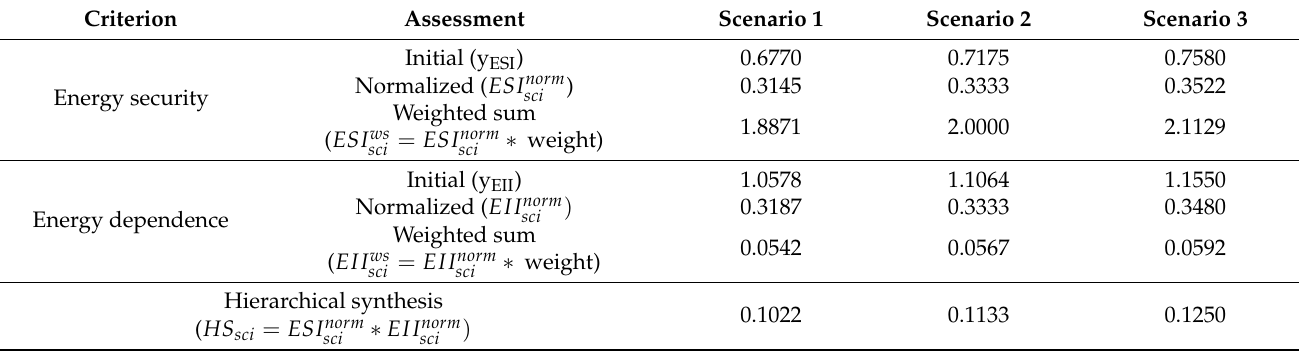
Table 9. Solution of the problem of nonlinear optimization by the Thomas L. Saaty method for the developed countries under